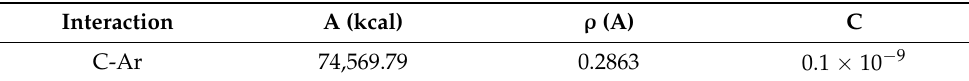
Table 3. Parameters of Buckingham potential for argon–carbon interaction.